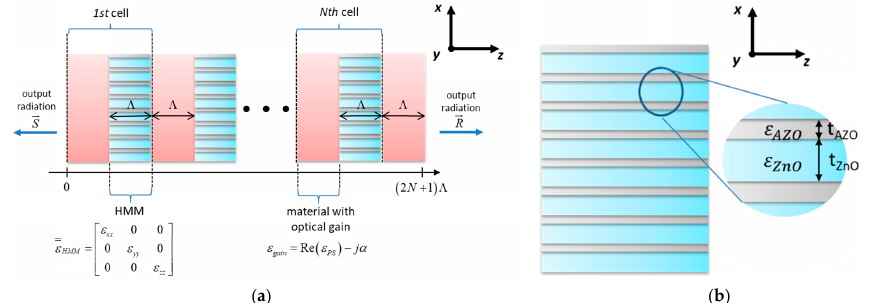
Figure 2. Scheme of a DFB laser based on photonic hypercrystal ( a ) and a hyperbolic metamaterial based on AZO and ZnO ( b ). Along with our previous research [25], amplitude gain coefficient, which is used for calculation of generation thresholds, is expressed in the following form: